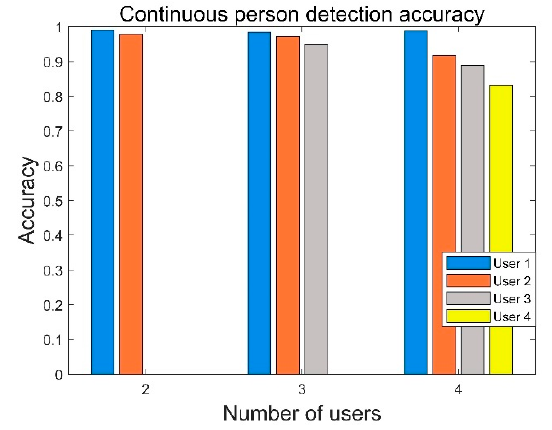
Figure 15. Performance of continuous person